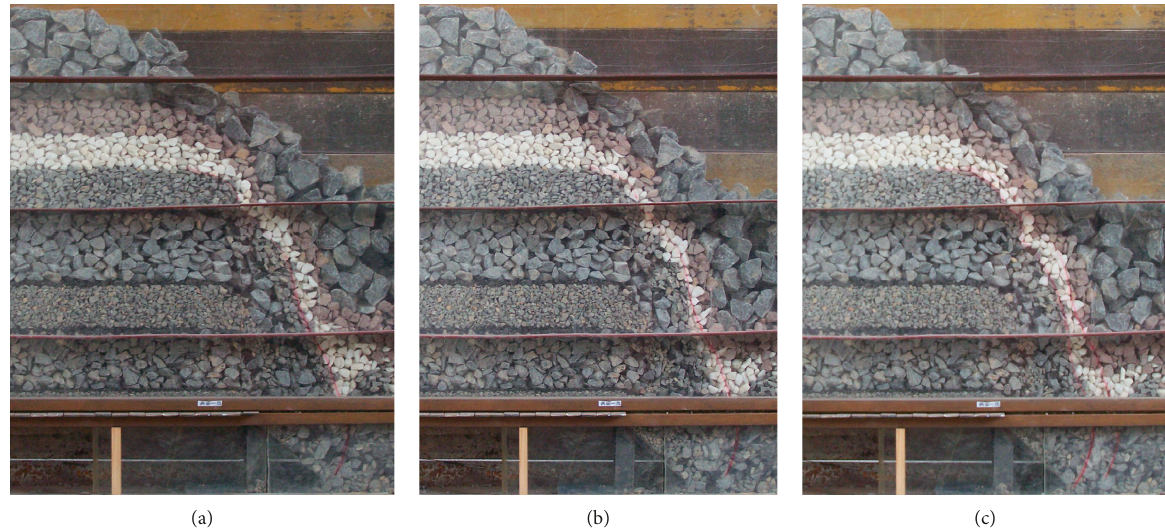
Figure 16: Dump top coal effect of two knife one falling. (a) Before relocation. (b) After relocation and before coal dumping. (c) After laying coal.